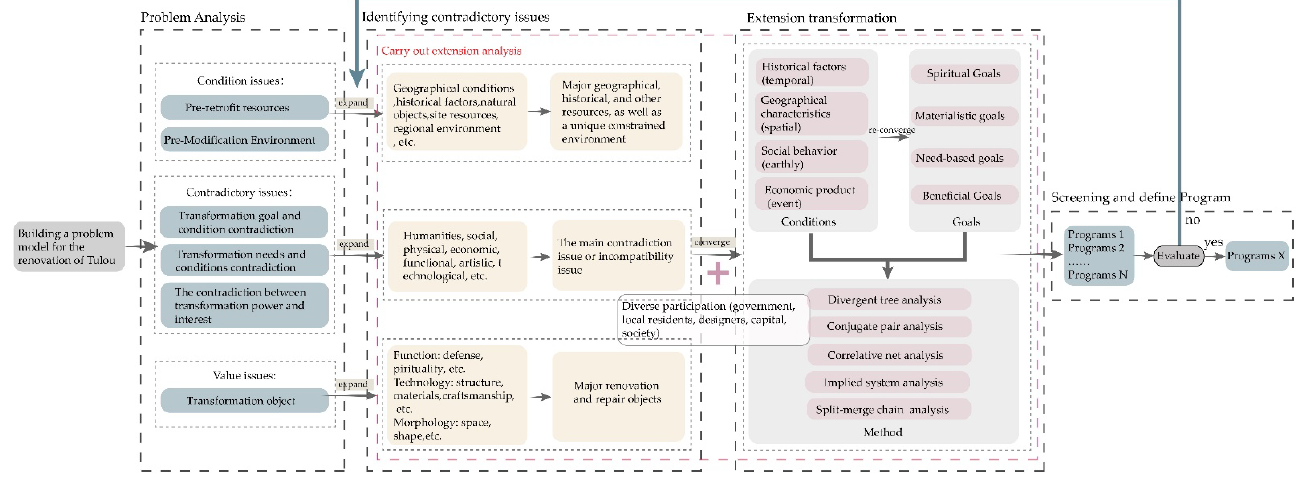
Figure 12. The renovation design system of the Tulou buildings [17] .